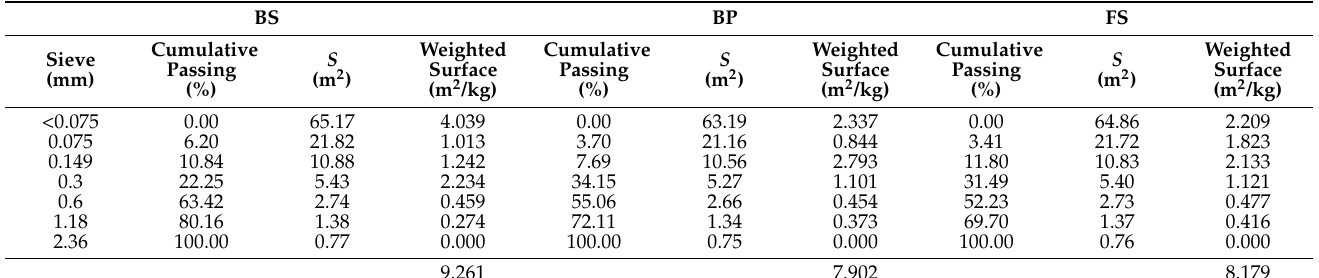
Table 4. Specific surface area of the three sands.